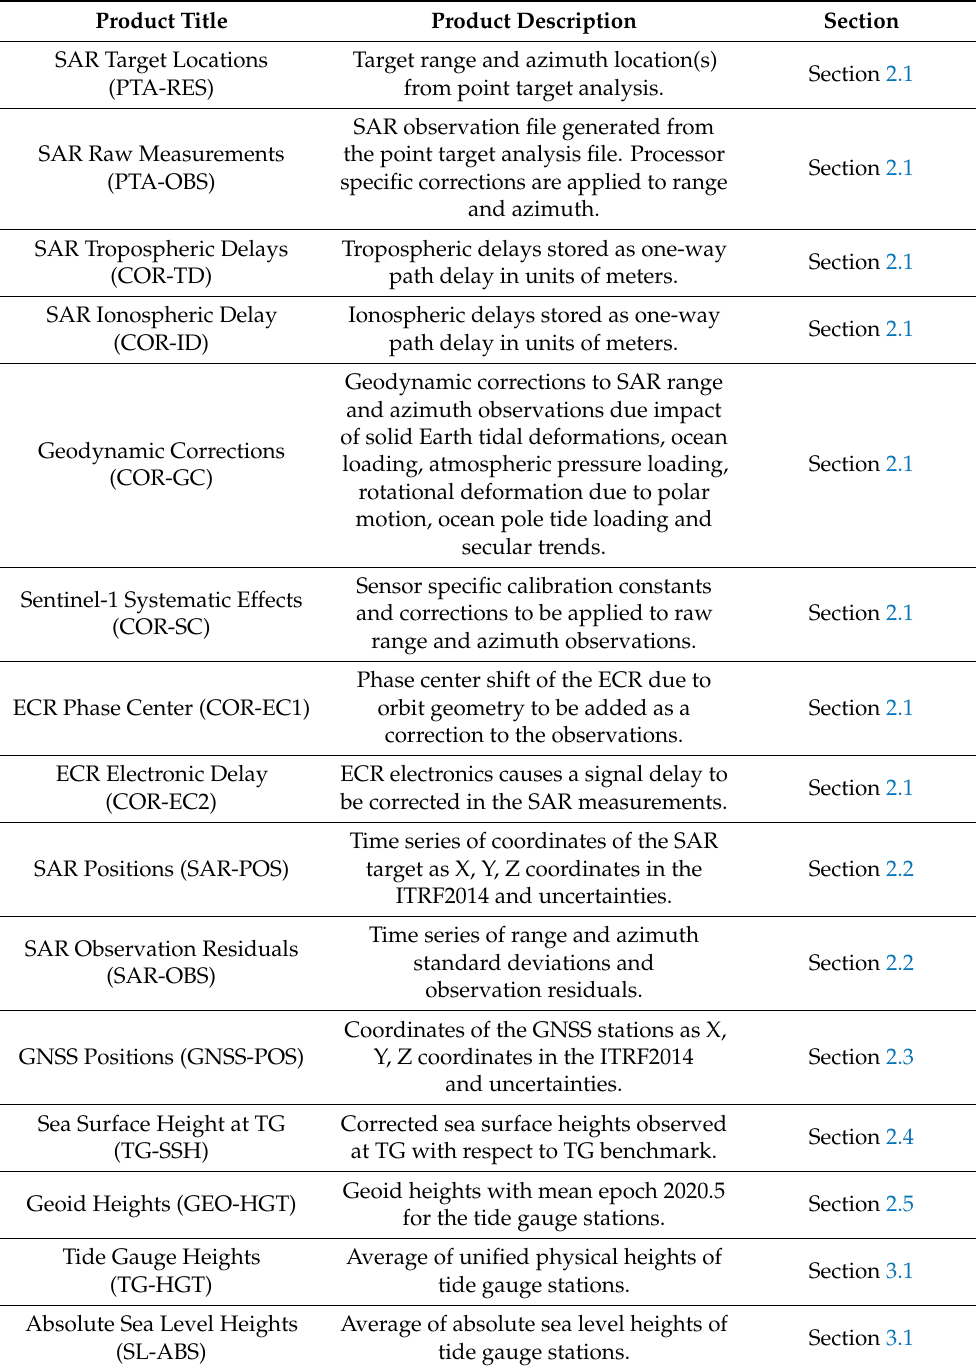
Table 15. Summary of data and